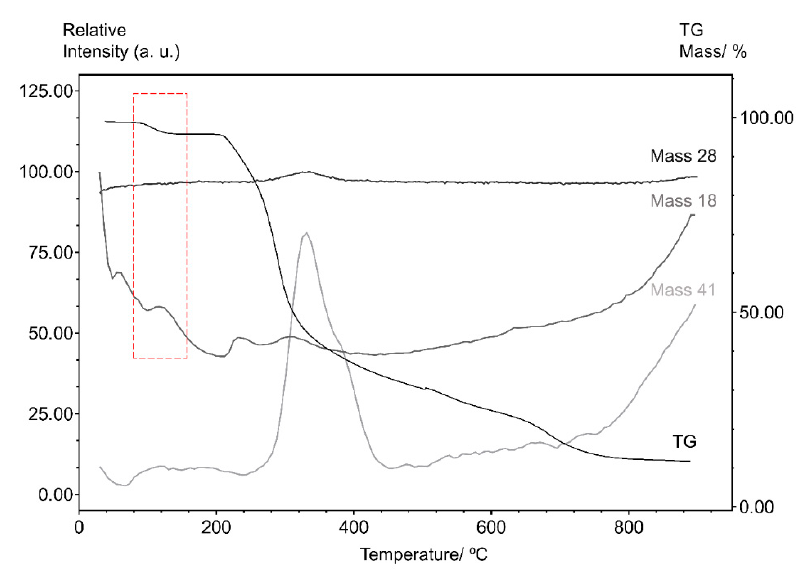
Figure 5. The thermogravimetric coupled with mass spectrometry (TG–MS) curves for sitagliptin phosphate monohydrate obtained with synthetic air atmosphere (50 mL min − 1 ), a heating rate of 10 °C min − 1 and 350 scans.